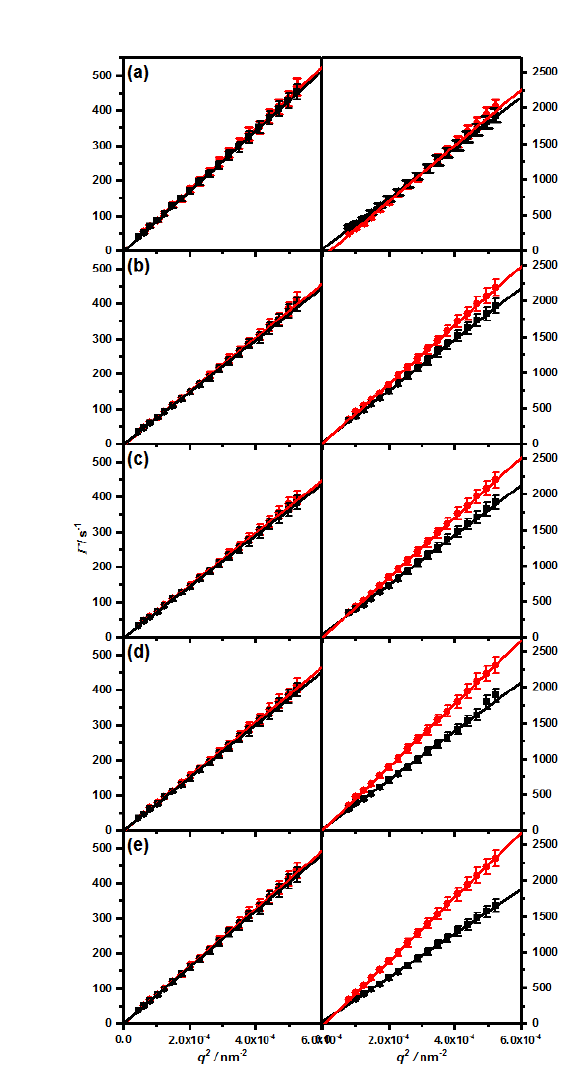
Figure A1. Angle-dependent PCS measurements of ( a ) PNN100/PMAM0; ( b ) PNN75/PMAM25; ( c ) PNN50/PMAM50; ( d ) PNN25/PMAM75 and ( e ) PNN0/PMAM100 at pH7 (black squares) and pH4 (red circles). All measurements were performed at 10 (left part of figure) and 55 ◦ C (right part of